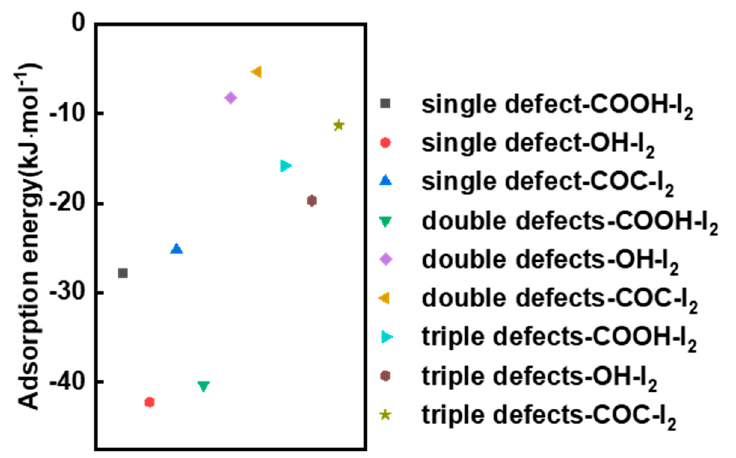
Figure 9. Optimized structures for single-defect structure ( a – c ), double-defects structure ( d – f ) and triple-defects structure ( g – i ) with B3LYP functional.